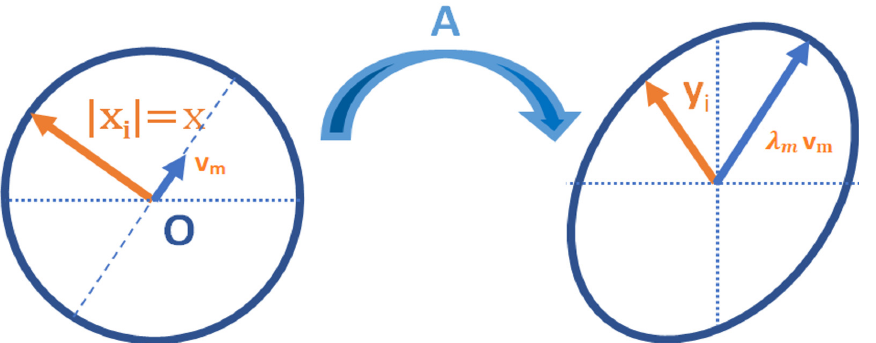
Figure 6. Manipulation of { 𝒙 𝒊 } with 𝐴 .